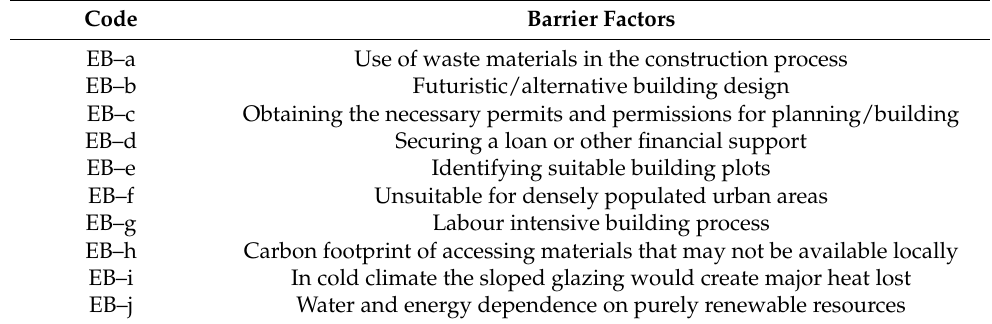
Table 5. List of barrier factors.